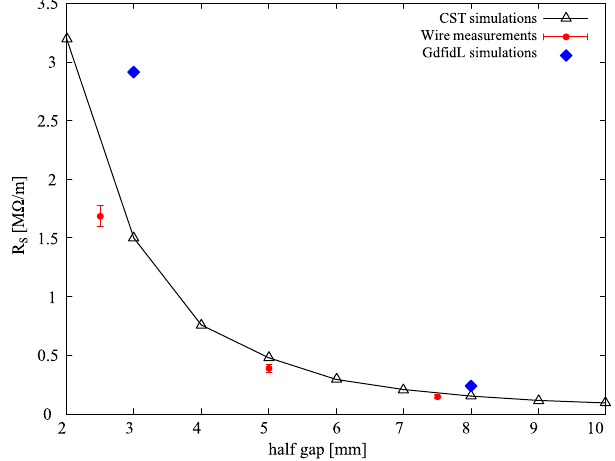
2016).FIG. 16. Shunt impedance R s of the 87 MHz mode versus half gap as measured with wire and simulated in CST and G dfid L .